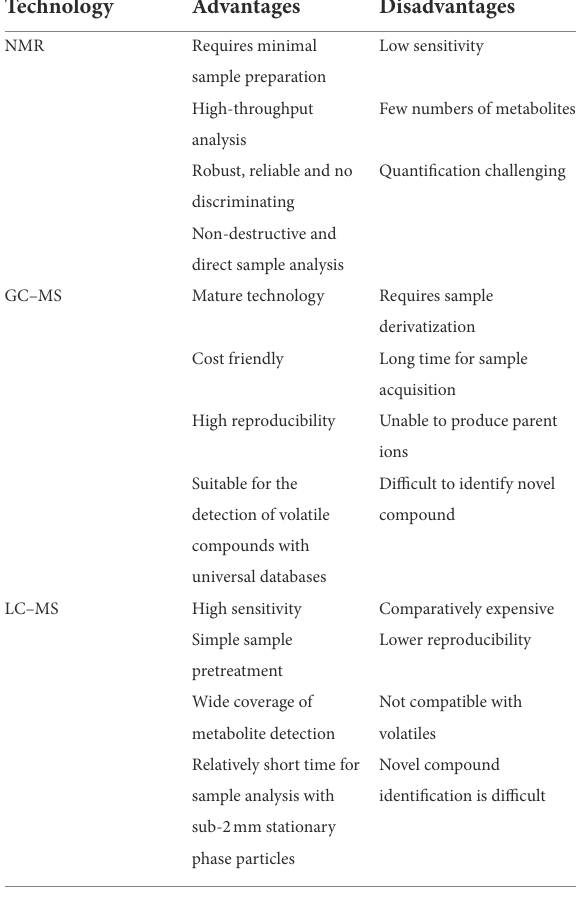
TABLE 1 Brief comparison of different metabolomic technologies.